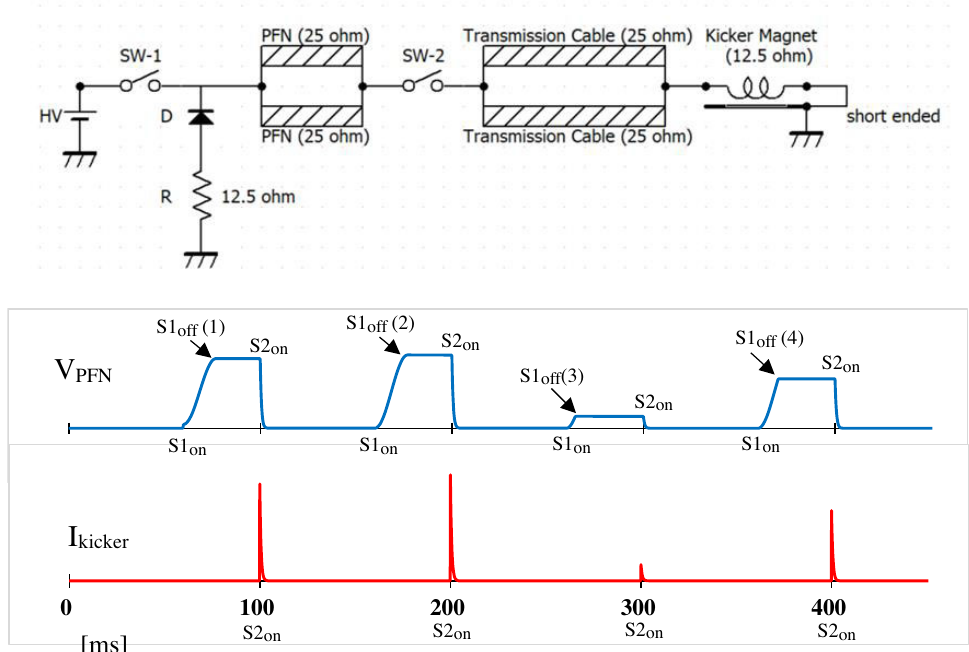
FIG. 11. Upper: equivalent circuit of the kicker magnet power supply; lower: charged voltage of the PFN ( 25 Ω ) and excitation current of the kicker magnet.